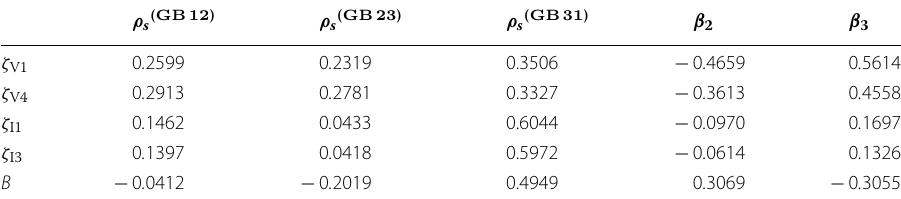
Table 2 Correlation coefficients between the TJ geometric/structural descriptors and TJ sink variables